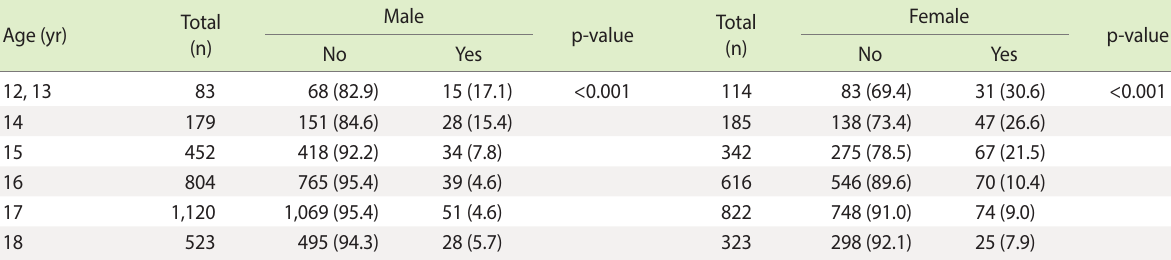
Table 2. Binge drinking experience (BDE) and suicide attempts Variable Non-drinking Non-BDE BDE Values are presented as number (%). Table 3. Binge drinking experience and suicide attempts in binge drinkers, by age Age